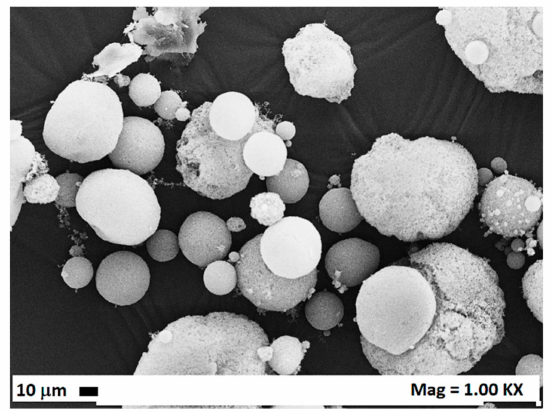
Figure 3. Expanded microparticles obtained at 9 MPa, 60 ◦ C and 20 mg /